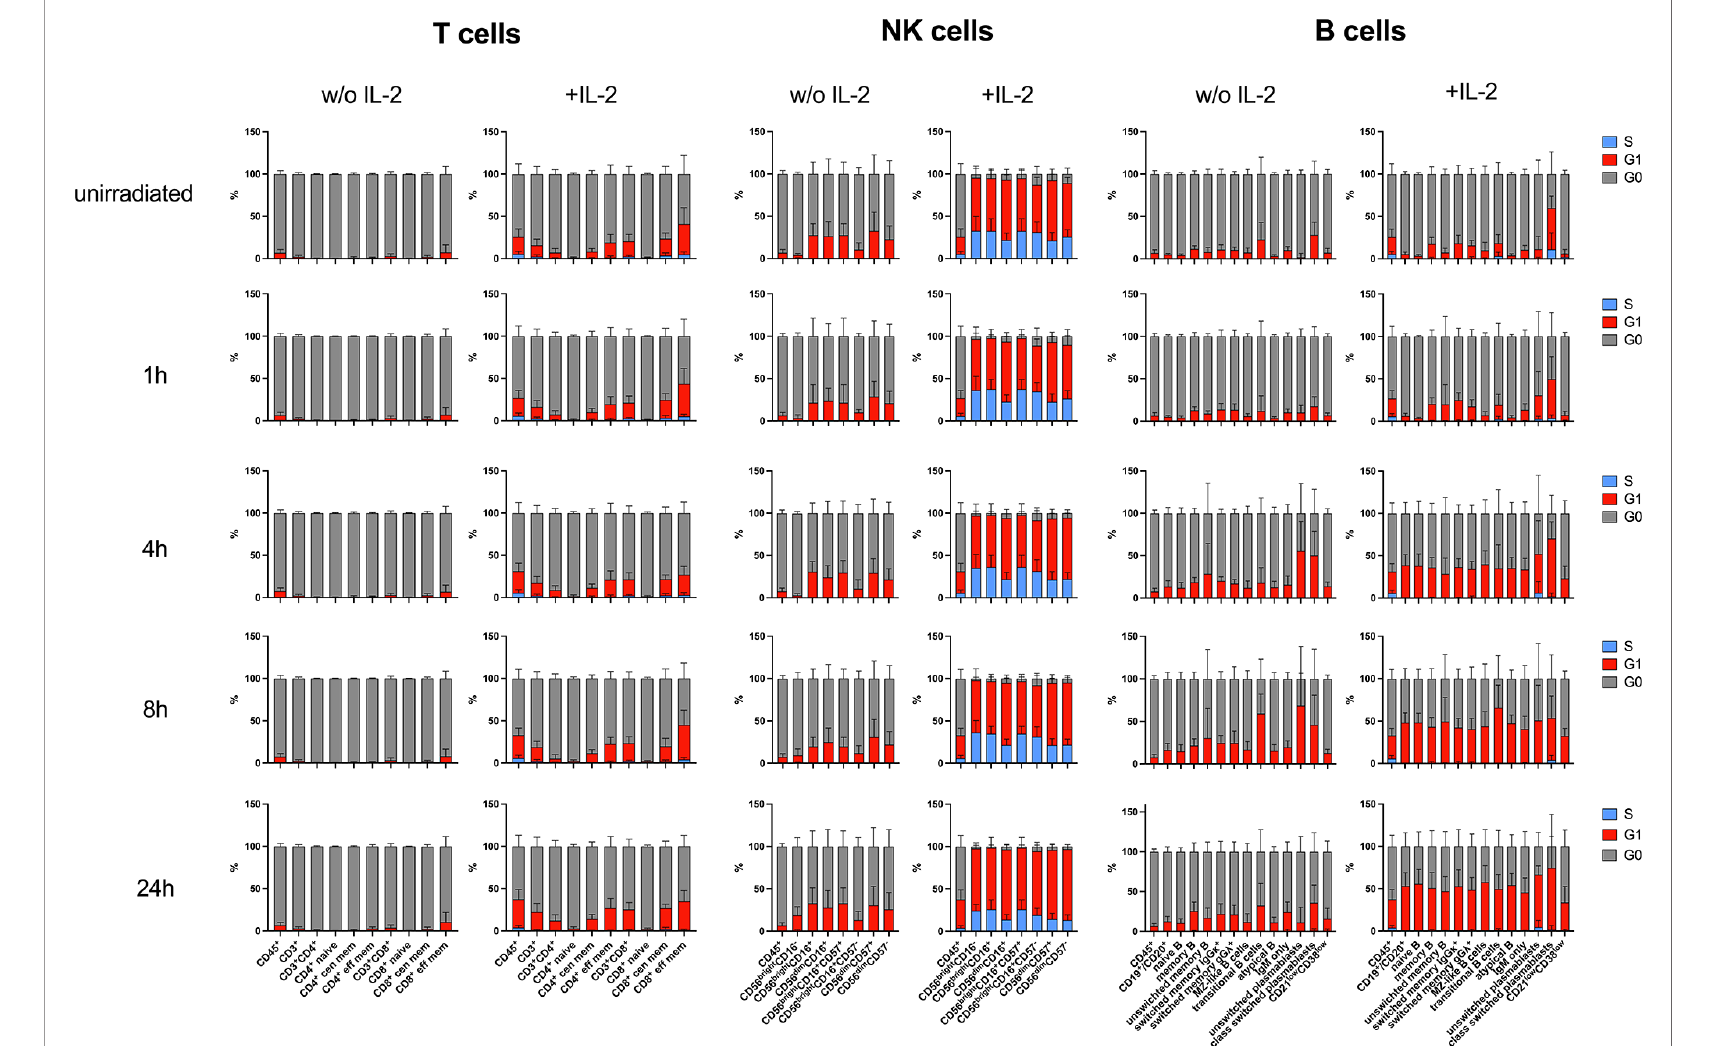
FIGURE 6 | Stimulation with IL-2 impacts on cell cycle of lymphocyte subsets. PBMCs of six healthy donors were cultured in RPMI media without (w/o) supplementation of IL-2 and in presence of 100U/ml human IL-2 for 48h. Cells were irradiated with 2Gy, and 30min before fi xation at indicated time points, IdU was added to cell culture to be incorporated in the DNA of replicating cells. Cell cycle was assessed by mass cytometry using ki67 and IdU to distinguish G0 (ki67 - IdU - ), G1 (ki67 + IdU - ) and S (ki67 + IdU + ) cell cycle phases. Bars represent mean percentages of cell cycle phases G0 (grey), G1 (red), and S (blue) in T, NK and B lymphocyte subsets of unirradiated lymphocytes and 1h, 4h, 8h, 24h after IR with 2Gy. CD45 + lymphocytes are shown in each panel as internal control. Error bars represent standard